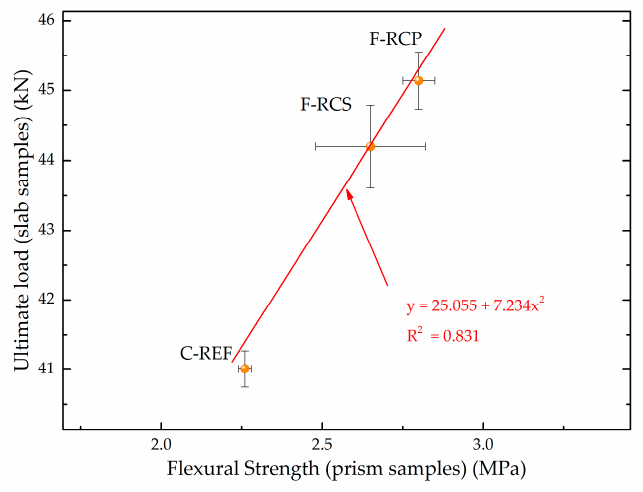
Figure 15. Correlation between flexural strength and ultimate load.